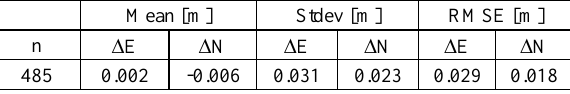
Table 4. Summary statistics of the horizontal error between mensurated and ground surveyed targets. Each target mensurated from each point cloud is included in the summary.